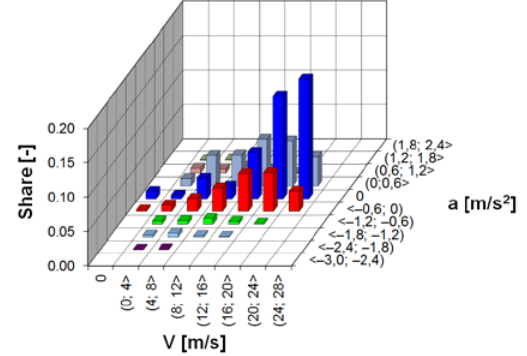
Fig. 4. Characteristics of the operating time share in the ranges of vehicle speed and acceleration